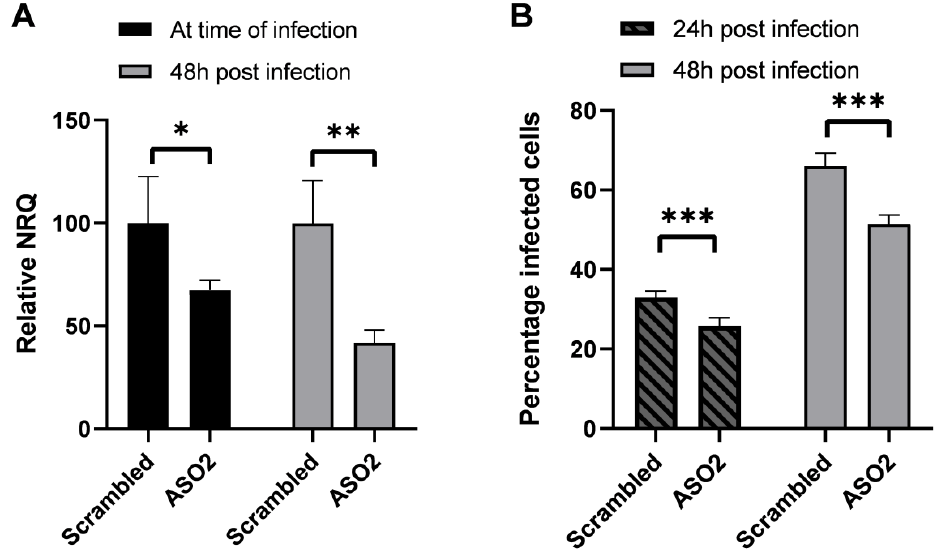
Figure 5. In vitro assessment of the impact of HEAL expression on HIV-1 infection in SupT1 cells. SupT1 cells were incubated with 5 µ M scrambled or HEAL targeting ASOs 48 h prior to infection. Cells were infected with NL4.3-GFP virus and monitored for 48 h. ( A ) Relative NRQs were generated for both pre- and post-infection samples. ( B ) Percentage of infected cells was determined using flow cytometry, quantifying the percentage of GFP positive cells. Student t -tests were performed to determine significance between two groups ( p < 0.05 *, p < 0.01 ** and p < 0.001 ***). All experiments were carried out in